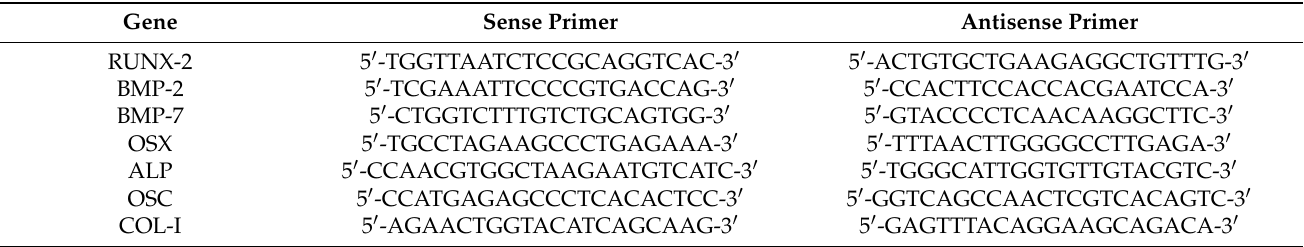
Table 1. Primer sequences for the amplification of osteoblasts’ cDNA by